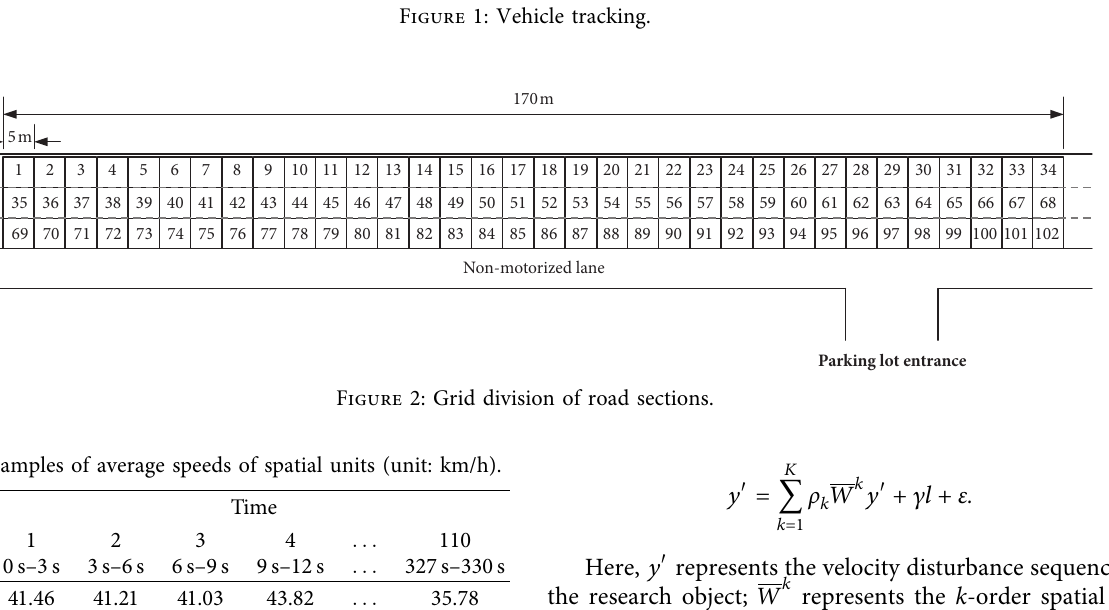
Figure 1: Vehicle